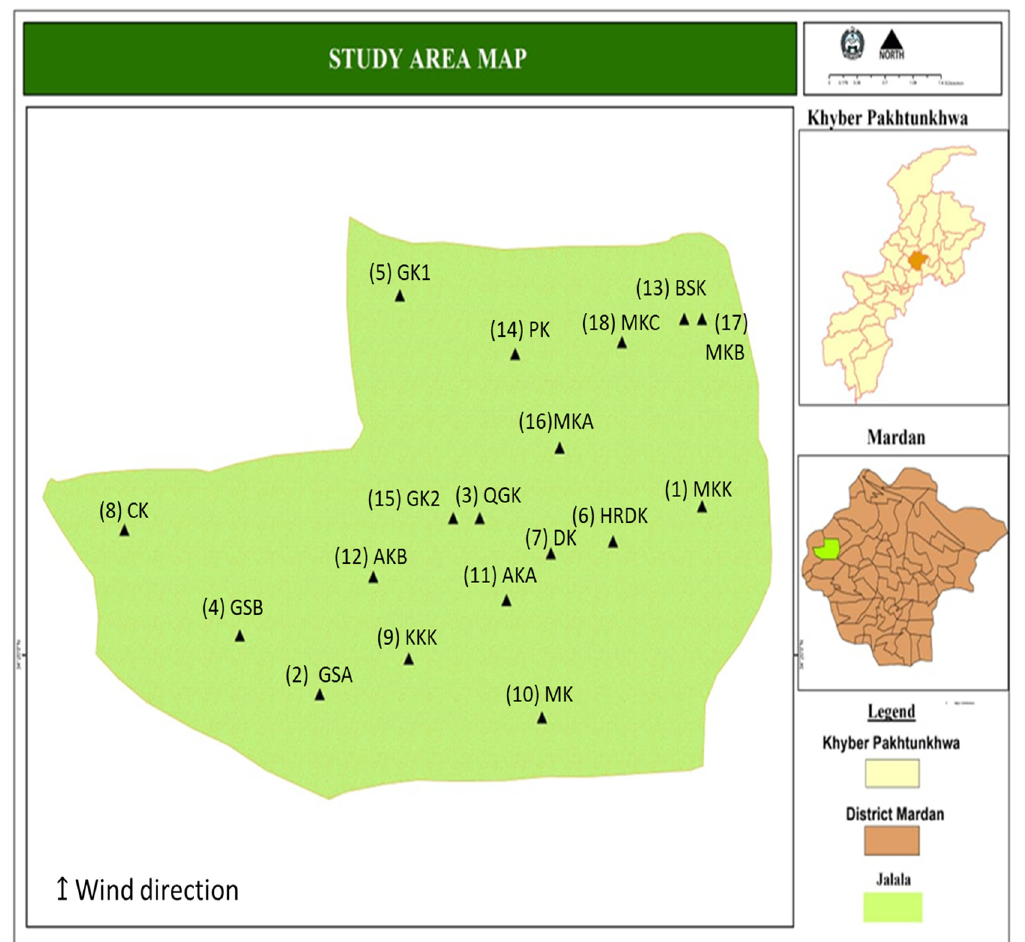
Figure 1. The present study area is Jalala, located in Mardan District in Khyber Pakhtunkhwa (northern Pakistan).